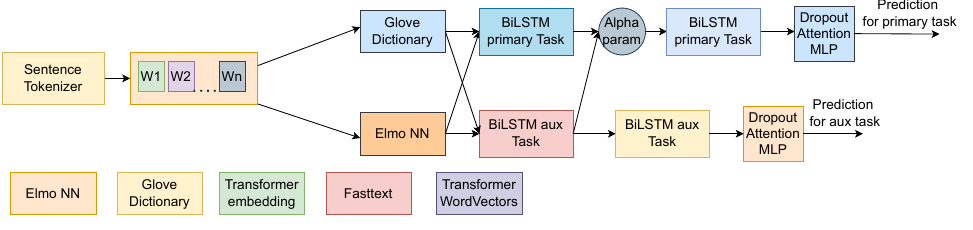
Figure 6. Multi-task